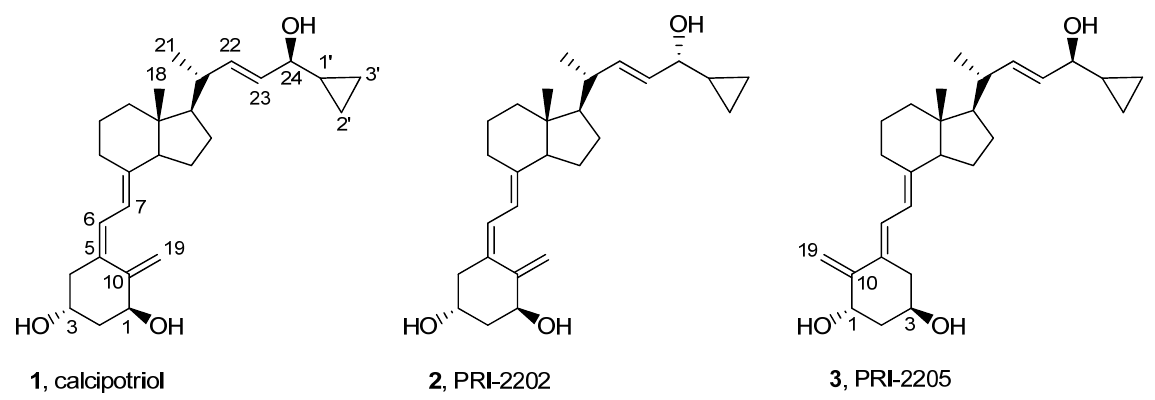
Figure 1. Structures of calcipotriol ( 1 , PRI-2201), its C-24 diastereomer ( 2 , PRI-2202) and geometric (5 E,7E ) analog ( 3 ,